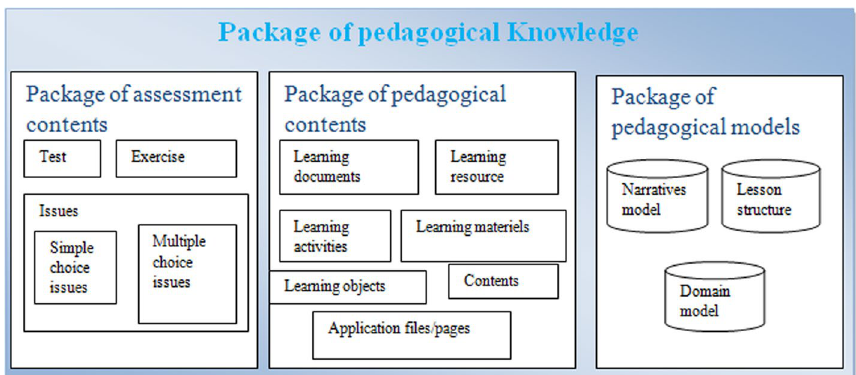
Fig. 6 Package of pedagogical